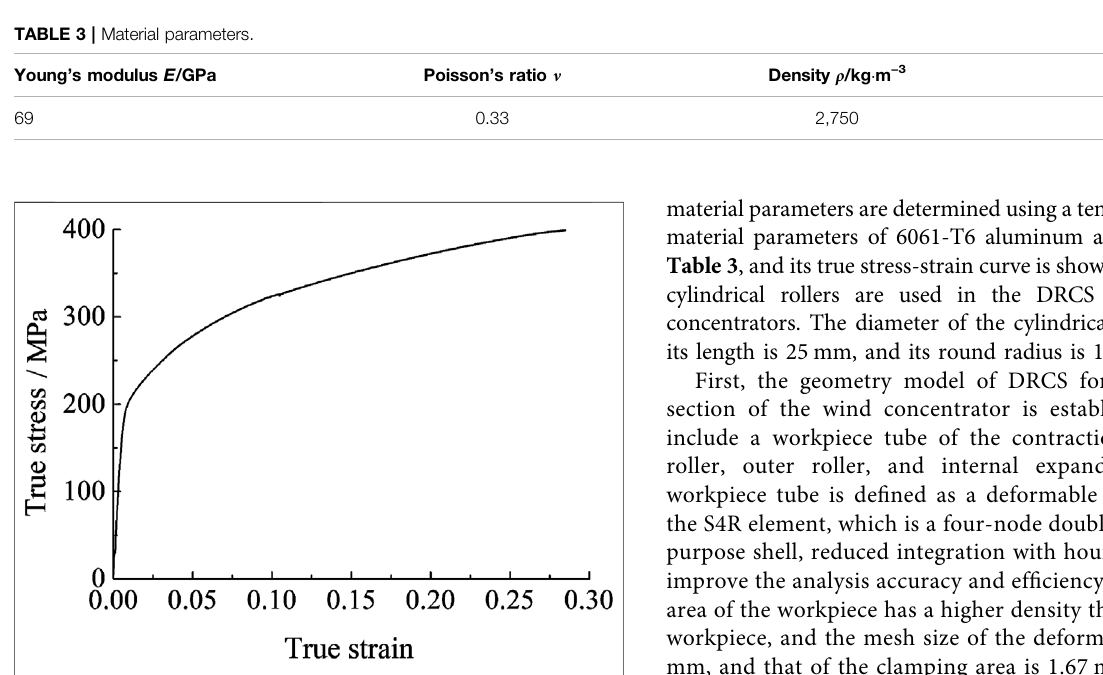
FIGURE 6 | True stress-strain curve for 6061-T6 aluminum